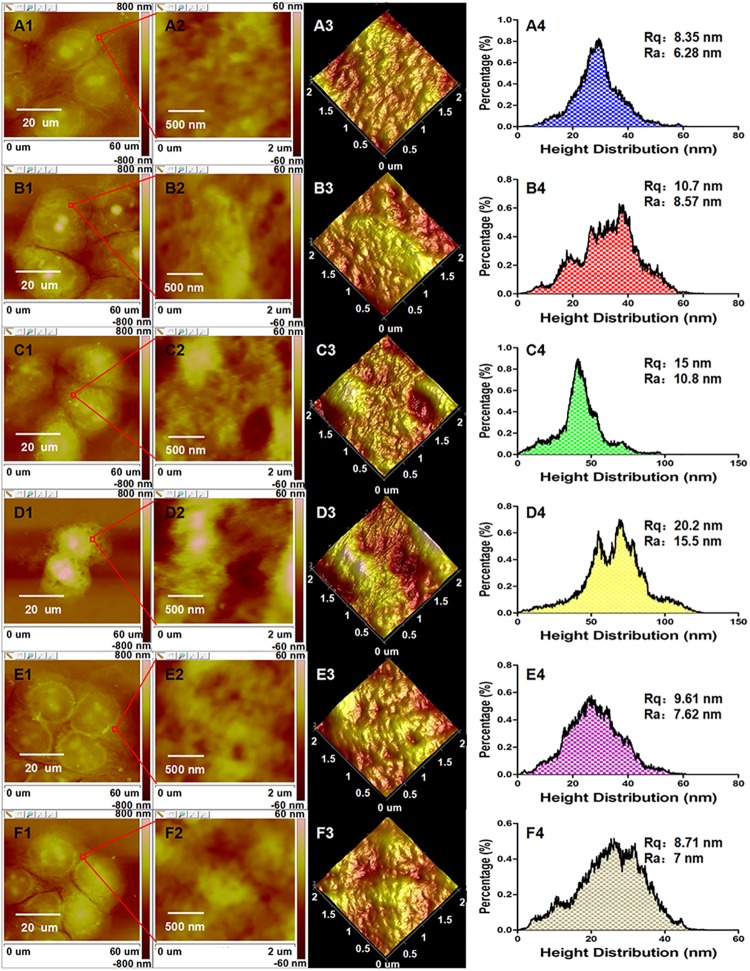
ROS scavenger-NAC reversed oridonin induced oesophageal cancer KYSE-150 cell membrane ultrastructural changes.AFM morphology and membrane ultrastructure imaging of (A) control, (B) 10 μM oridonin treated, (C) 30 μM oridonin treated, (D) 50 μM oridonin treated, (E) 2.5 mM NAC+50 μM oridonin treated and (F) 2.5mM NAC treated KYSE-150 cells. (A1-F1) Topogrphy images of KYSE-150 cells, scale bar: 20 μm; (A2-F2) Enlarged membrane ultrastructure images in (A1-F1) and (A3-F3) their corresponding 3D images of KYSE-150 cells, scale bar: 500 nm; (A4-F4) Height distribution and roughness of cell surface ultrastructure analyzed from (A2-F2).